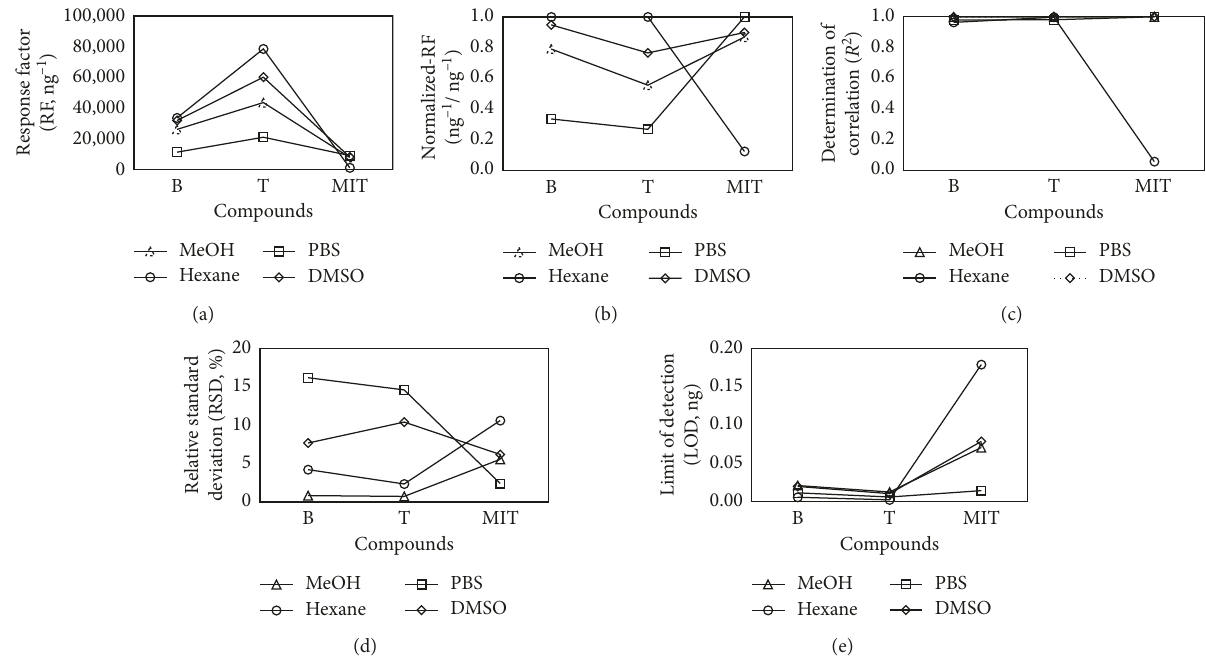
F IGURE 3: Plots of the calibration results from the three target compounds (B, T, and MIT) according to the four different solvents. (a) Response factor. (b) Normalized-RF. (c) Determination of correlation. (d) Relative standard deviation. (e) Limit of